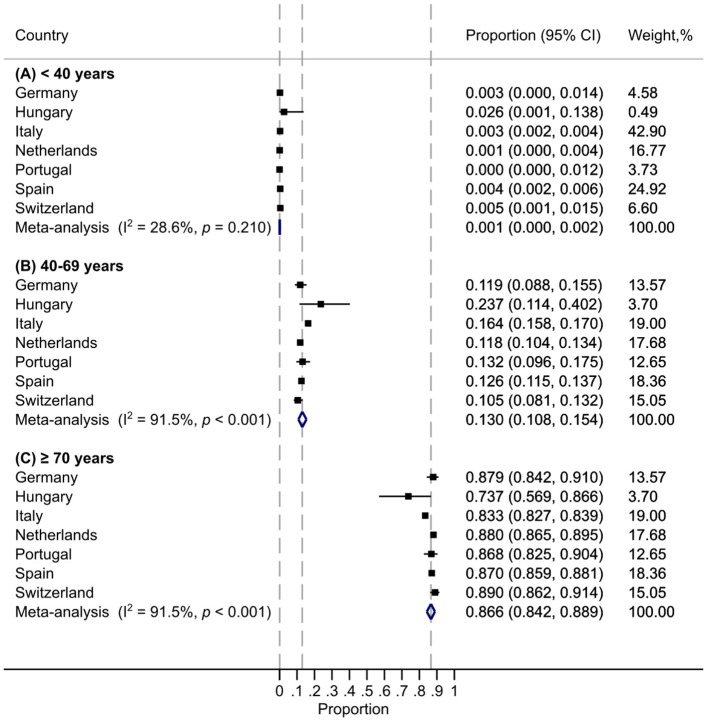
Distribution of age groups for all COVID-19–related deaths in Europe: meta-analysis. Each vertical dashed line is aligned with the meta-analysis summary estimate of the corresponding age group.